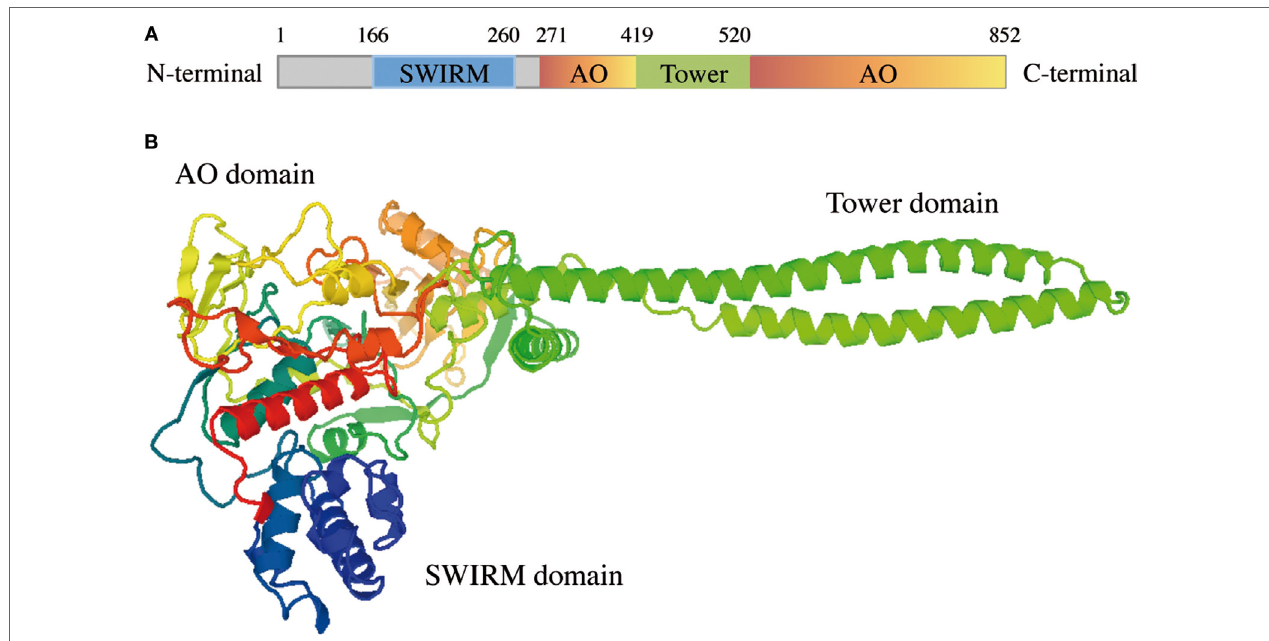
FigURe 1 | LSD1 protein structure. (A) Schematic illustration of LSD1 domains. (B) Tridimensional structure of LSD1; domains are colored as in (A) . The image was obtained from SWISS-MODEL protein structure homology-modeling server